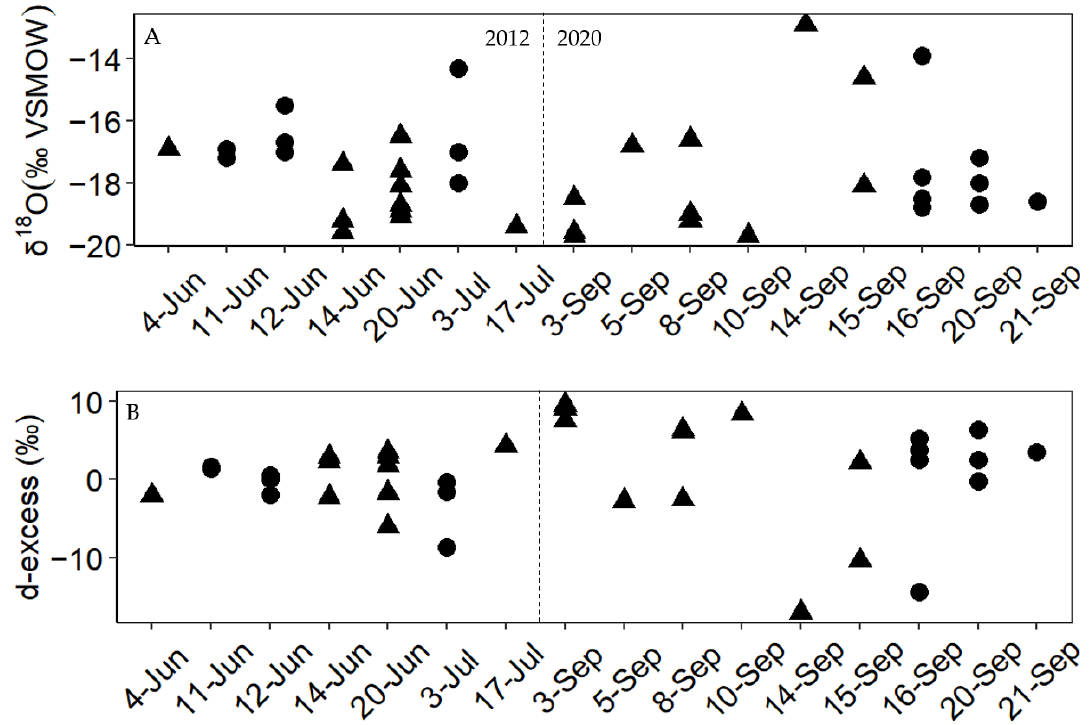
Figure 8. Time-series distribution of δ 18 O ( A ) and d-excess ( B ) values from extensive sites for each sampling period in 2012 and 2020. Natural Subregions are depicted by shape for clarity. The Montane Natural Subregion is represented by circles and the Subalpine Natural Subregion is represented by triangles.